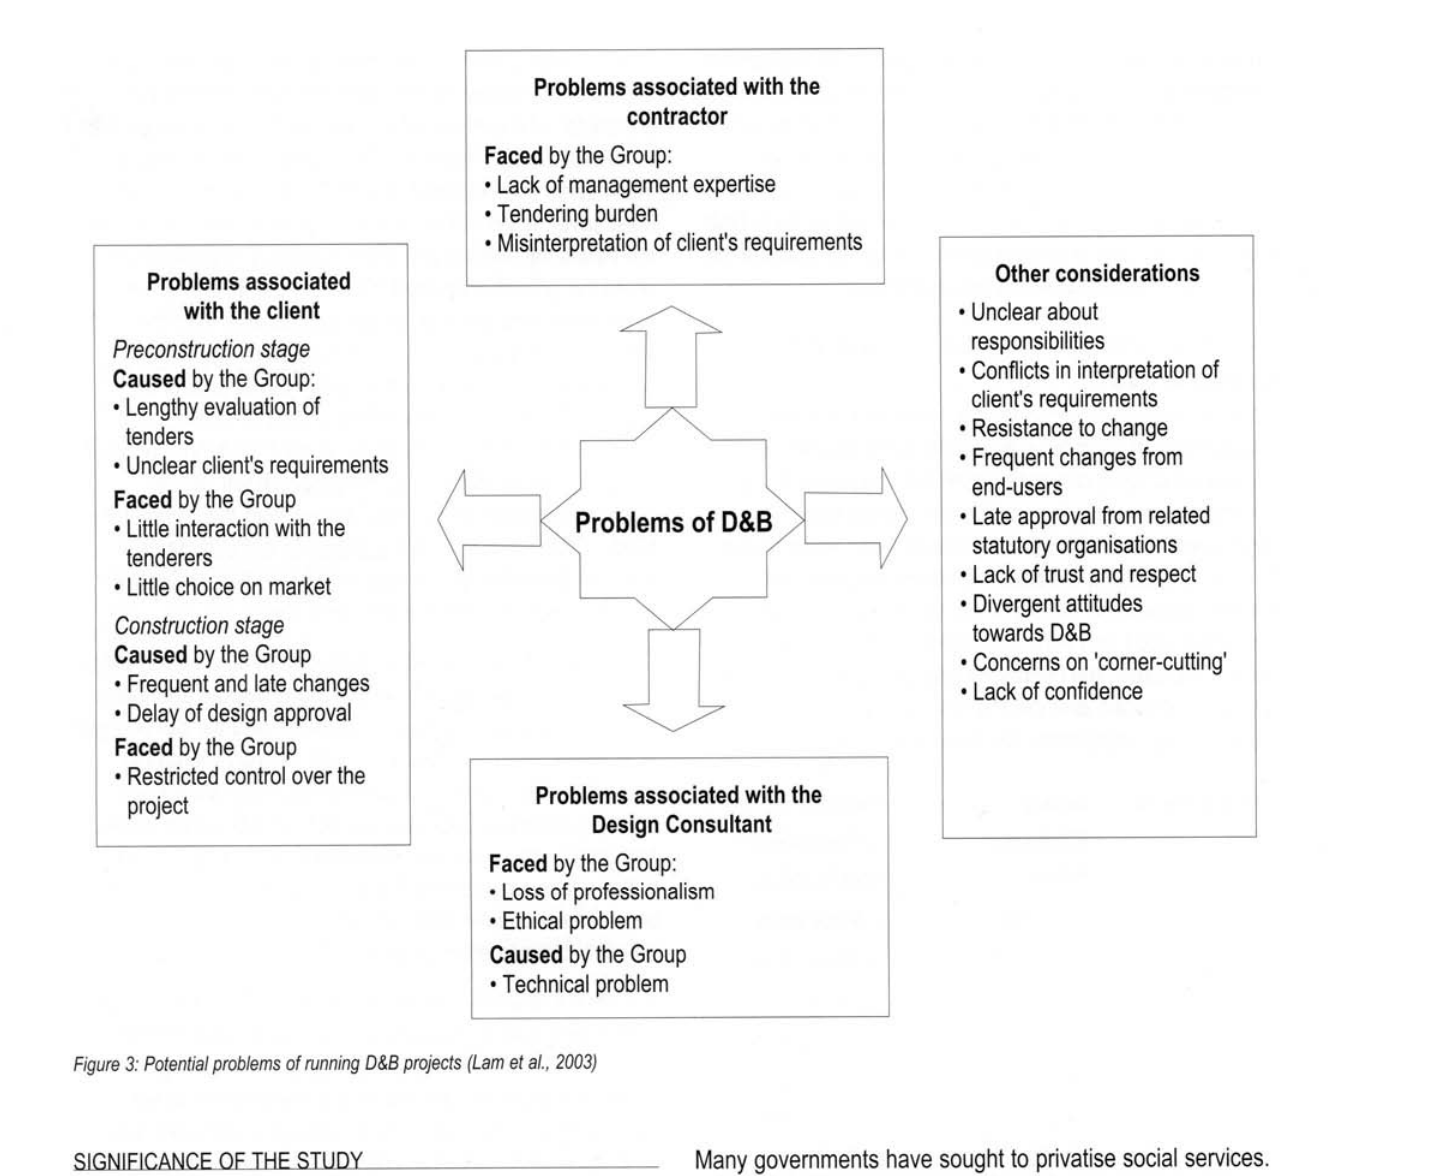
SIGNIFICANCE OF THE